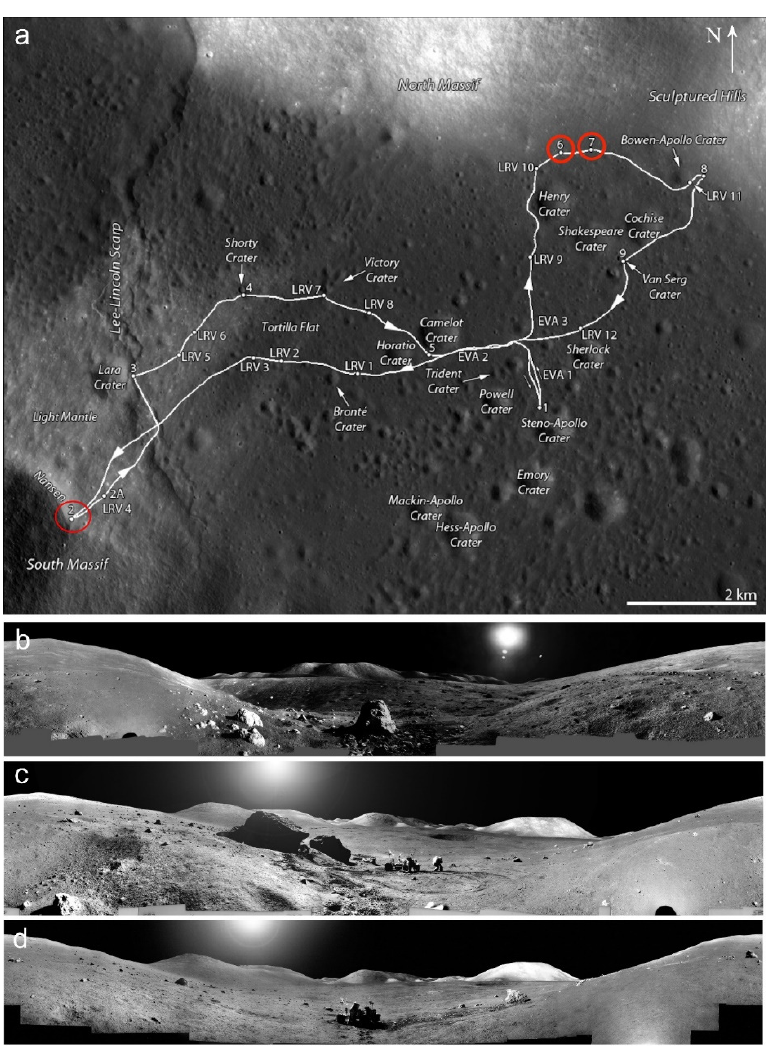
Figure 1. ( a ) Apollo 17 traverse map (adapted from [15]) showing the localization of Stations 2, 6, and 7 (red circles). ( b ) Panorama taken by E. Cernan at Station 2 (frames AS17-137-20926 to 20956). ( c ) Panorama taken by at H. H. Schmitt at Station 6 (frames AS17-141-21575 to 21603), showing several boulder fragments to the left of the lunar roving vehicle (LRV). ( d ) Panorama taken by E. Cernan at station 7 (frames AS17-146-22339 to 22363). The main boulder is on the right of the LRV.